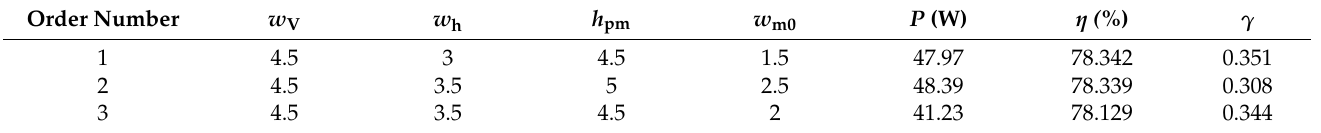
Table 6. BBD orthogonal test